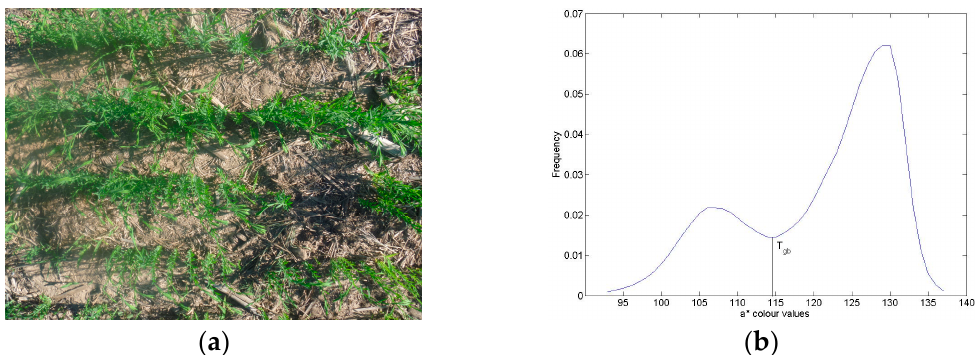
Figure 2. An image of flax ( a ) and the smoothed probability distribution of its a* color values ( b ). T gb is the threshold for segmentation in the ACE algorithm.